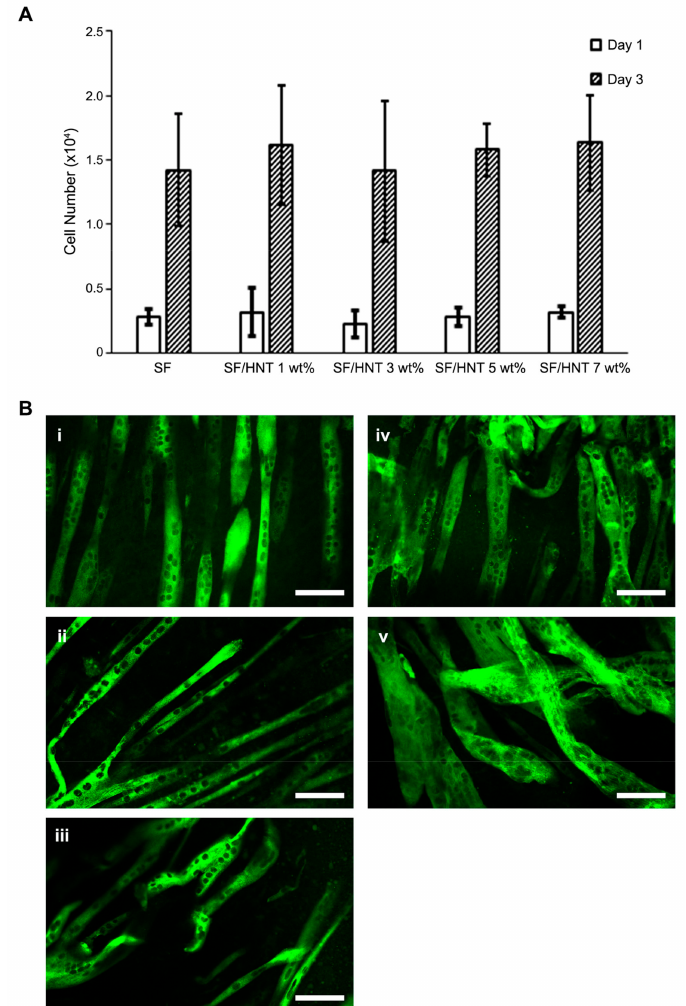
Figure 7. Myoblasts proliferate and differentiate on the scaffolds. ( A ) C2C12 myoblast proliferation on SF and SF/HNTs scaffolds after 1 and 3 days of culture. Data are means ± SD of 6 replicates. Data are representative of three independent experiments. Statistical analyses were ANOVA followed by Tukey’s test; p > 0.5, no significant differences were detected. ( B ) C2C12 cell differentiation. Cells were stained with an anti-myosin antibody (green) to reveal myotubes: SF ( i ), SF/HNT 1 wt% ( ii ), SF/HNT 3 wt% ( iii ), SF/HNT 5 wt% ( iv ), SF/HNT 7 wt% ( v ); scale bar: 100 µ